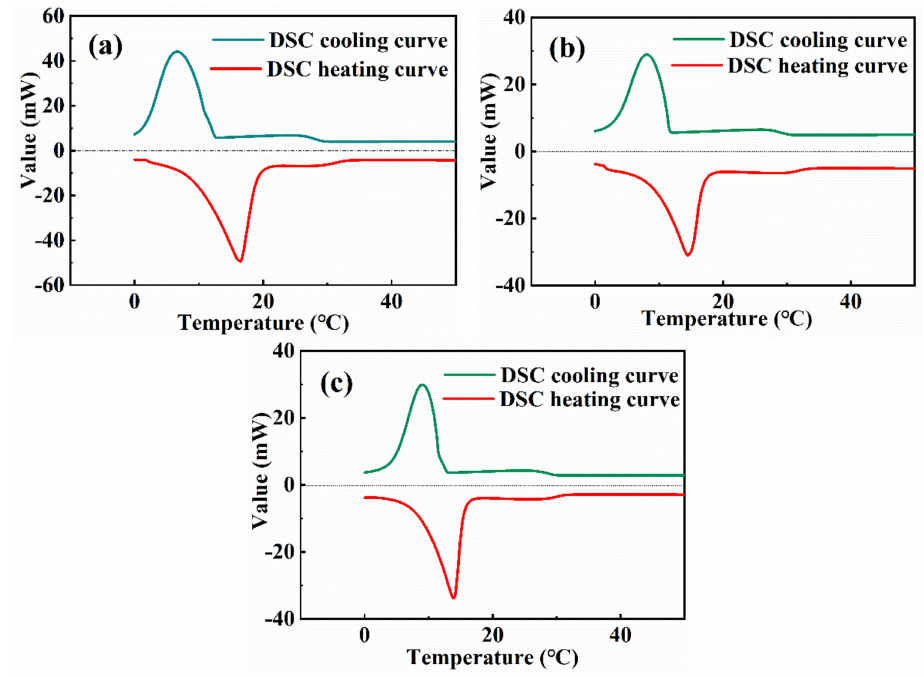
Figure 11. DSC curves of ( a ) PCM, ( b ) MPCM-1, and ( c ) MPCM-2. Table 6. Phase-change